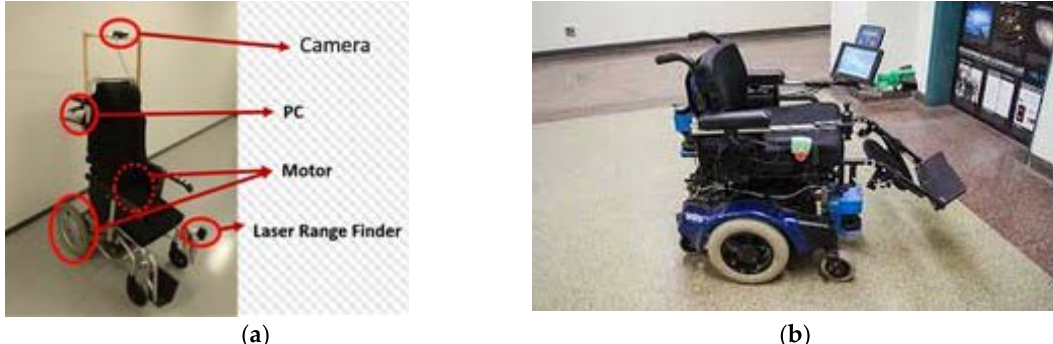
Figure 4. ( a ) An intelligent wheelchair example with motor, PC, camera, and laser range sensor. ( b ) Smart multi-task wheelchair (McGill SmartWheeler Project). ( a ) Source: